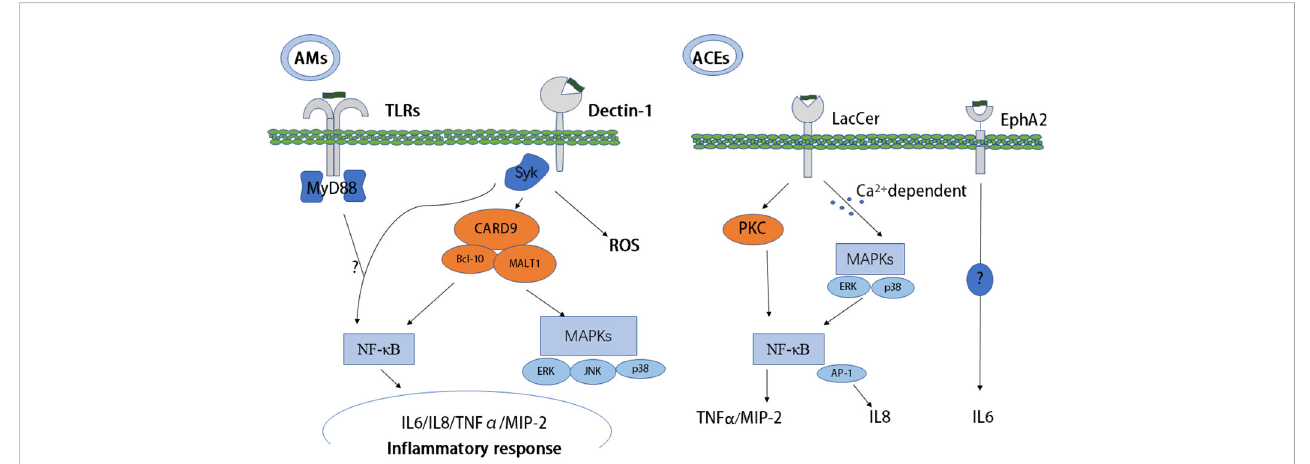
FIGURE 1 Host recognition of PCBG and PCBG-mediated initial immunity. Dectin-1, TLRs, EphA2, and LacCer as receptors recognize PCBG and mediate initial immunity resulting in an in fl ammatory response. Collaboration between dectin-1 and TLRs to mediate the NF- k B pathway is unclear, and the signaling pathway of EphA2 is also very unclear. AMs, alveolar macrophages; MyD88, myeloid differentiation primary response 88; NF- k B, nuclear factor kappa- light-chain-enhancer of activated B cells; PC, Pneumocystis ; SYK, spleen tyrosine kinase; TLRs, Toll-like receptors; EphA2, ephrin type-A receptor 2; MIP-2, macrophage in fl ammatory protein 2, TNF- a , tumor necrosis factor-alpha; AECs, alveolar epithelial cells; PCBG, Pneumocystis carinii cell wall constituent b -1,3-glucan; LacCer,